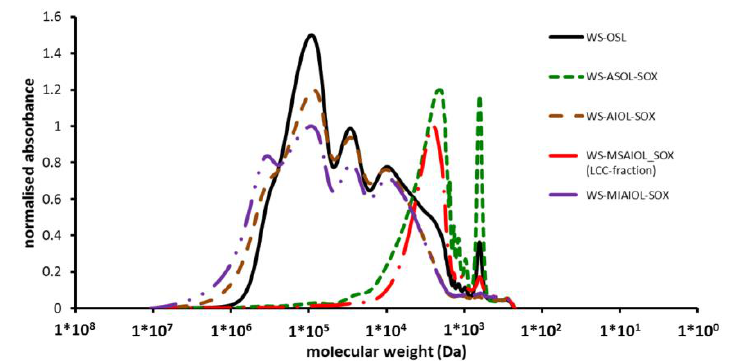
Figure 3. GPC-analyses of WS-OSL and Soxhlet-derived fractions thereof.